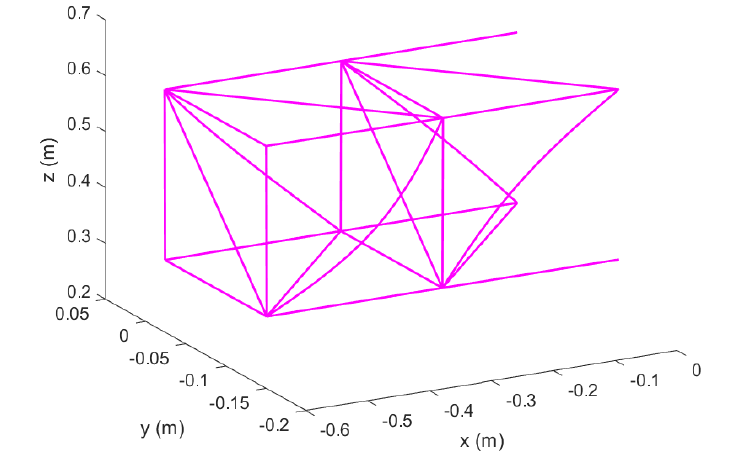
Figure 36. Mode 4 of Timoshenko beams in Topology 1 with hinged ends; spanwise expanded configuration.